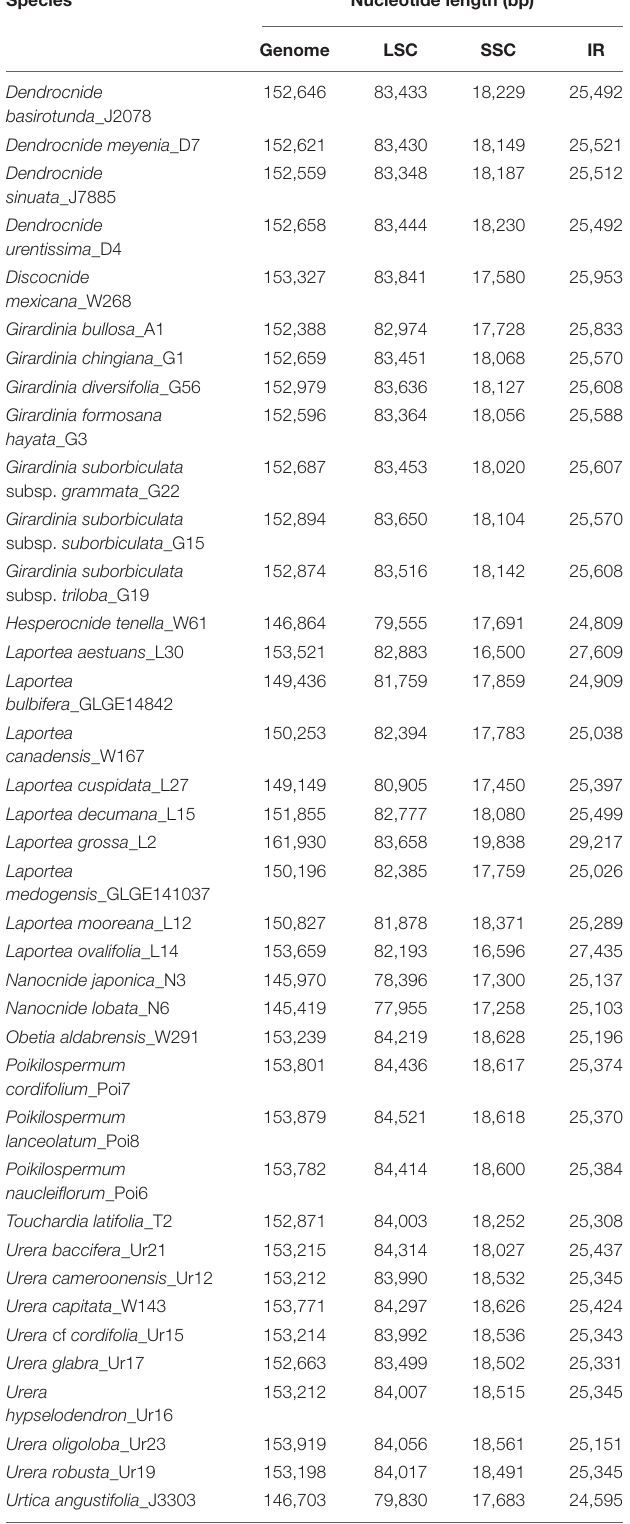
TABLE 1 | Summary of sizes of the whole Urticeae plastomes, and the three compartments. Species Nucleotide length